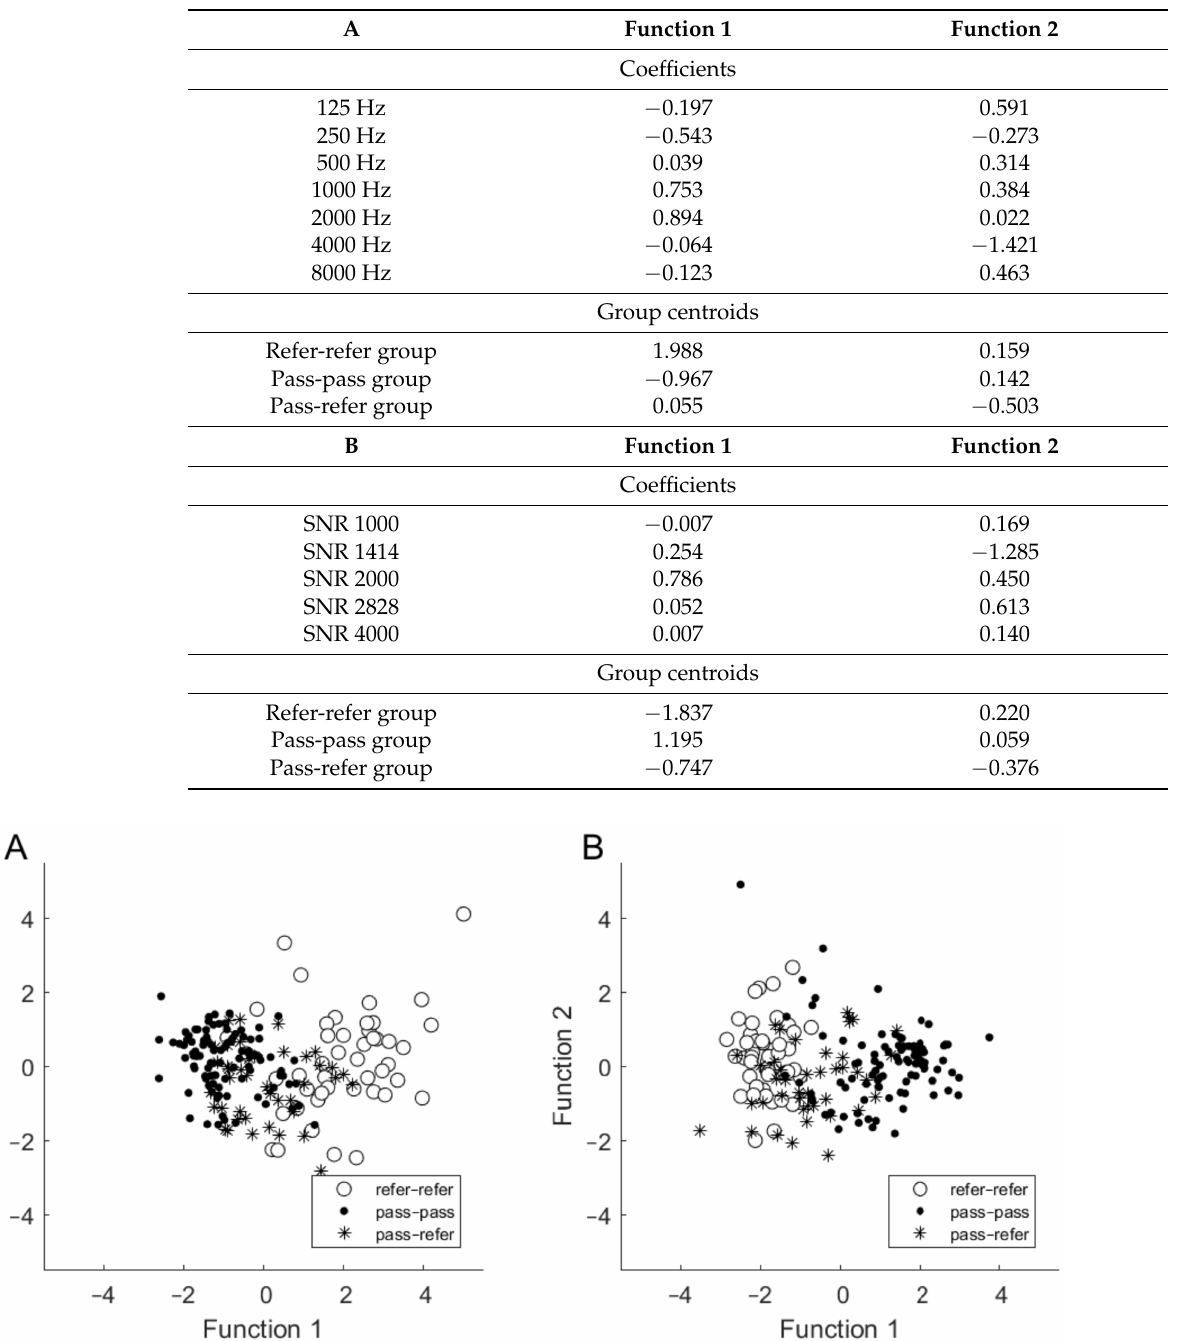
Table 4. Results of discrimination analysis based on PTA thresholds ( A ) and on SNR results ( B ).